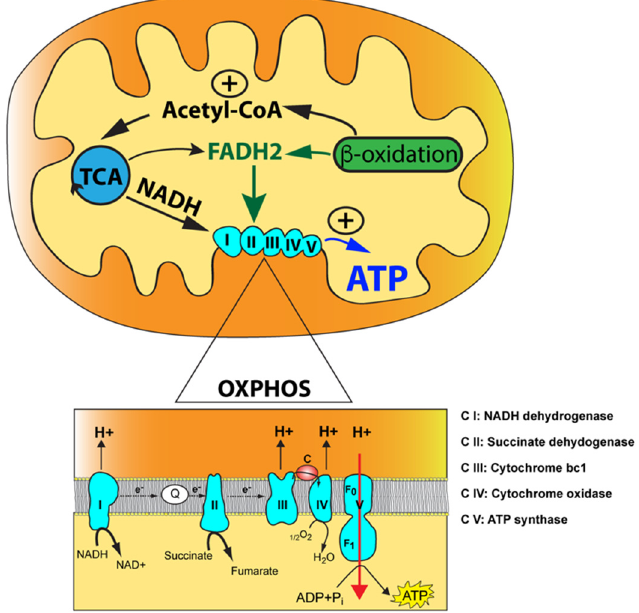
Figure 1. The mitochondrial oxidative phosphorylation (OXPHOS) enzymatic machinery and key metabolic pathways. The mitochondrion is illustrated with its outer mitochondrial membrane, inner mitochondrial membrane, and mitochondrial matrix (yellow) along with the tricarboxylic acid (TCA) cycle and the fatty acid beta-oxidation with their functional link via acetyl-CoA. The reducing agents, NADH and FADH2, produced by the tricarboxylic acid (TCA) cycle and fatty acid beta-oxidation, are indicated along with their two points of entry in the OXPHOS pathway. Magnification of the OXPHOS enzymatic machinery with electrons transfer via the two-electron carriers, coenzyme Q10 (Q) and cytochrome c (c), is shown below. The electron donor, succinate, a product of the TCA cycle, is also indicated acting at the level of complex II. Finally, protons translocated from complexes I, III, and IV into the intermembrane space (orange) are shown along with protons being transferred back into the mitochondrial matrix via complex V, resulting in ATP synthesis from ADP and inorganic phosphate (Pi).